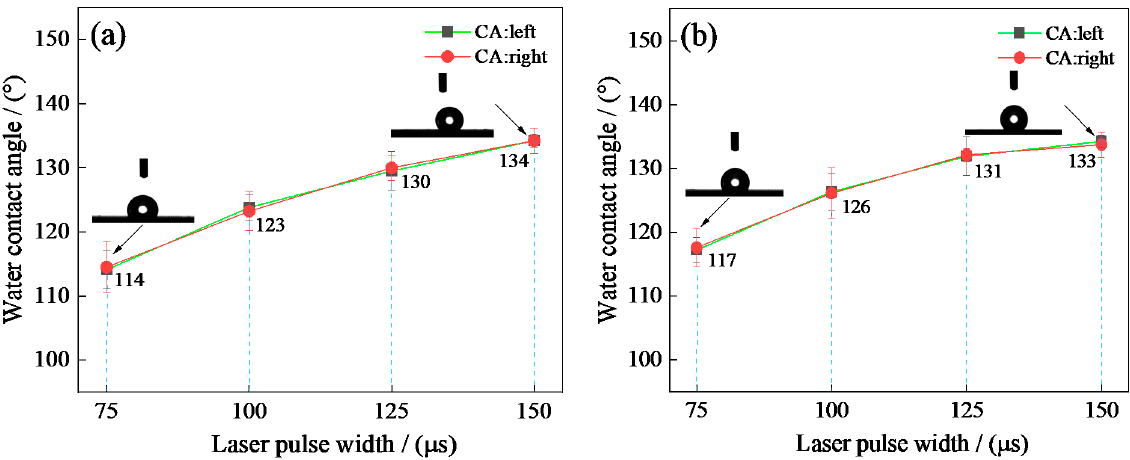
Figure 13. Effect of laser pulse width on textured surface water contact angle: ( a ) P = 50 W; ( b ) P = 60 W.